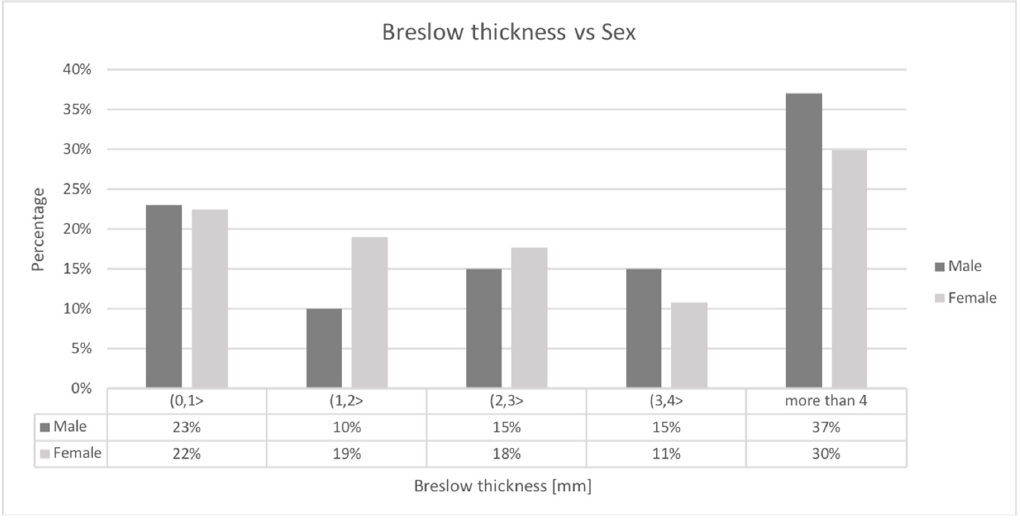
Figure 6. Breslow thickness in male and female in HFM patients. Legend: HFM—hand and foot melanoma.